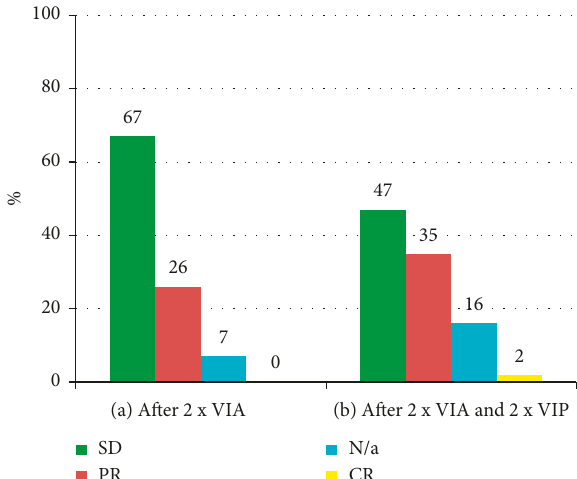
Figure 4: (a) Radiological response evaluation after 2 cycles of VIA and (b) radiological response evaluation after 2 cycles of VIA and 2 cycles of VIP according to RECIST 1.1. SD: stable disease; PR: partial response; CR: complete response; N/a: nonevaluable; RECIST: Response Evaluation Criteria in Solid Tumors; VIA: vincristine, ifosfamide, and doxorubicin; VIP: etoposide, ifosfa- mide, and